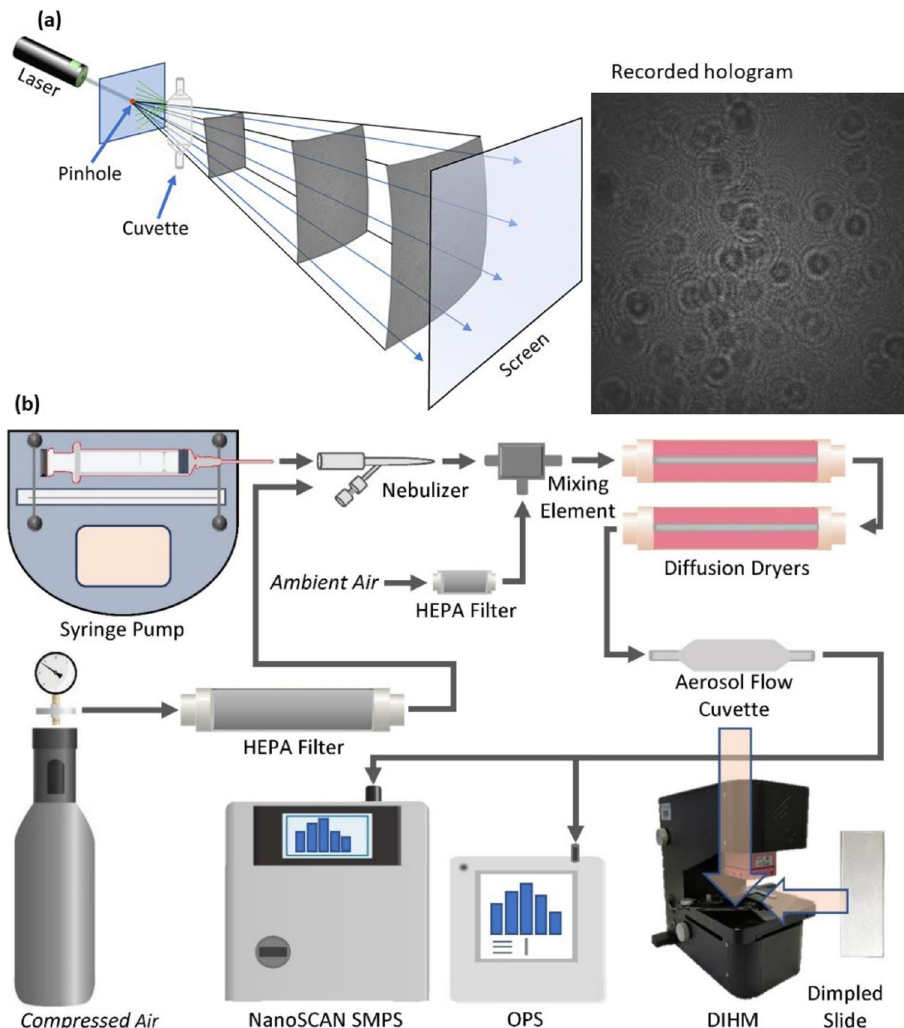
Fig. 9 Digital in-line holography microscopy setup. a Schematic showing the operational principle of DIHM and a recorded hologram. b Schematic of the experimental setup for holographic imaging in moving air fl ows, stationary liquid, and solid samples by